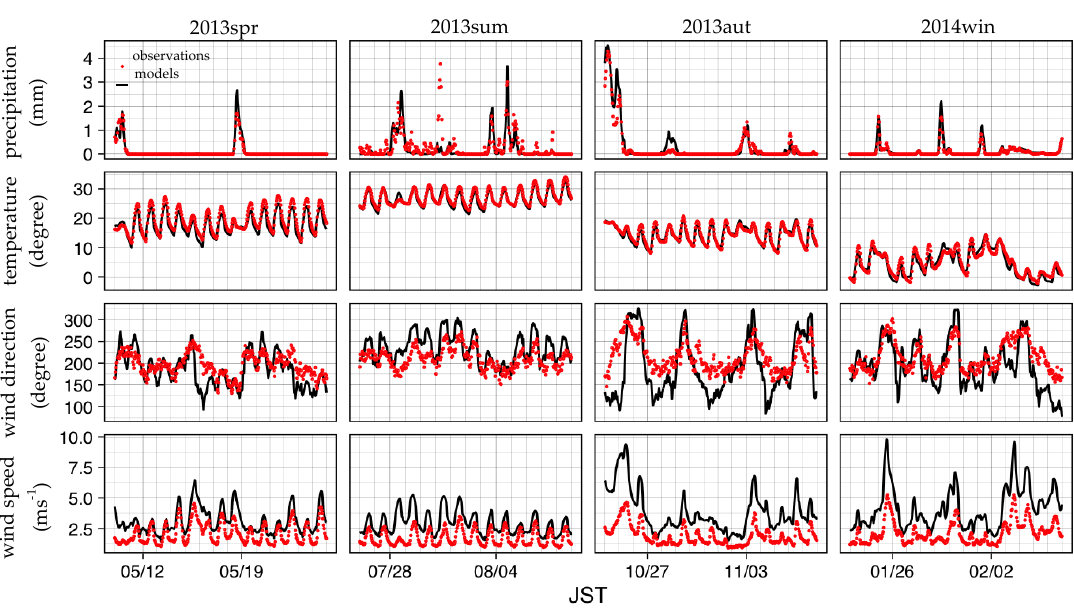
Figure 2. Spatially averaged precipitation, temperature, wind direction, and wind speed over four seasons. These results are based on hourly observed values and simulated at all JMA stations for d03.